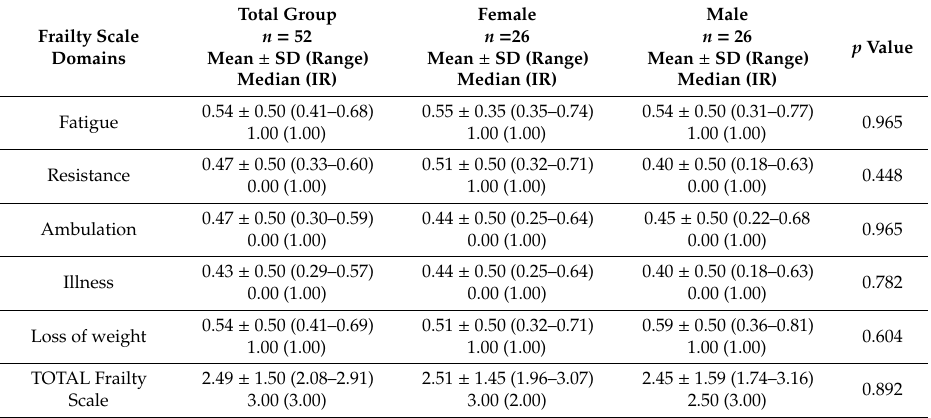
Table 2. Comparisons of the 5-Frailty scale scores between males and